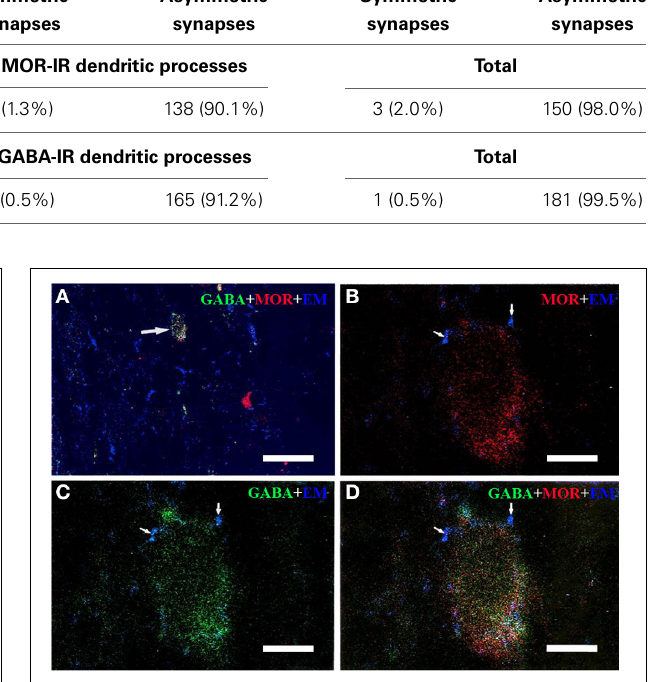
FIGURE 2 | Immunofluorescent histochemical triple-staining showing the connections between EM2-immunoreactive (IR) terminals (A–D, blue) and neuronal cell bodies exhibiting both MOR-IR (B, red) and GABA-IR (C, green) positive staining in lamina II of the Vc. The merged image in (D) reveals close contacts between EM2-IR axon terminals and MOR/GABA co-localized neuronal cell bodies (yellow). The arrow in (A) showed a MOR/GABA co-localized neuron connecting with EM2-IR axonal terminals. The arrows in (B–D) showed connections between EM2-IR axonal terminals and MOR or GABA-IR neuronal cell body. Scale bars = 45 μ m (A) , 6 μ m (in B–D ). triple-immunofluorescent histochemical staining also revealed that approximately 58% of the MOR-IR neurons or 79.8% of the GABA-IR neurons expressed FOS protein principally in lam- ina II of the Vc ( Table 3 ); 27.6% and 47.7% of the FOS-IR and MOR-IR neurons co-expressed MOR and FOS ( Table 3